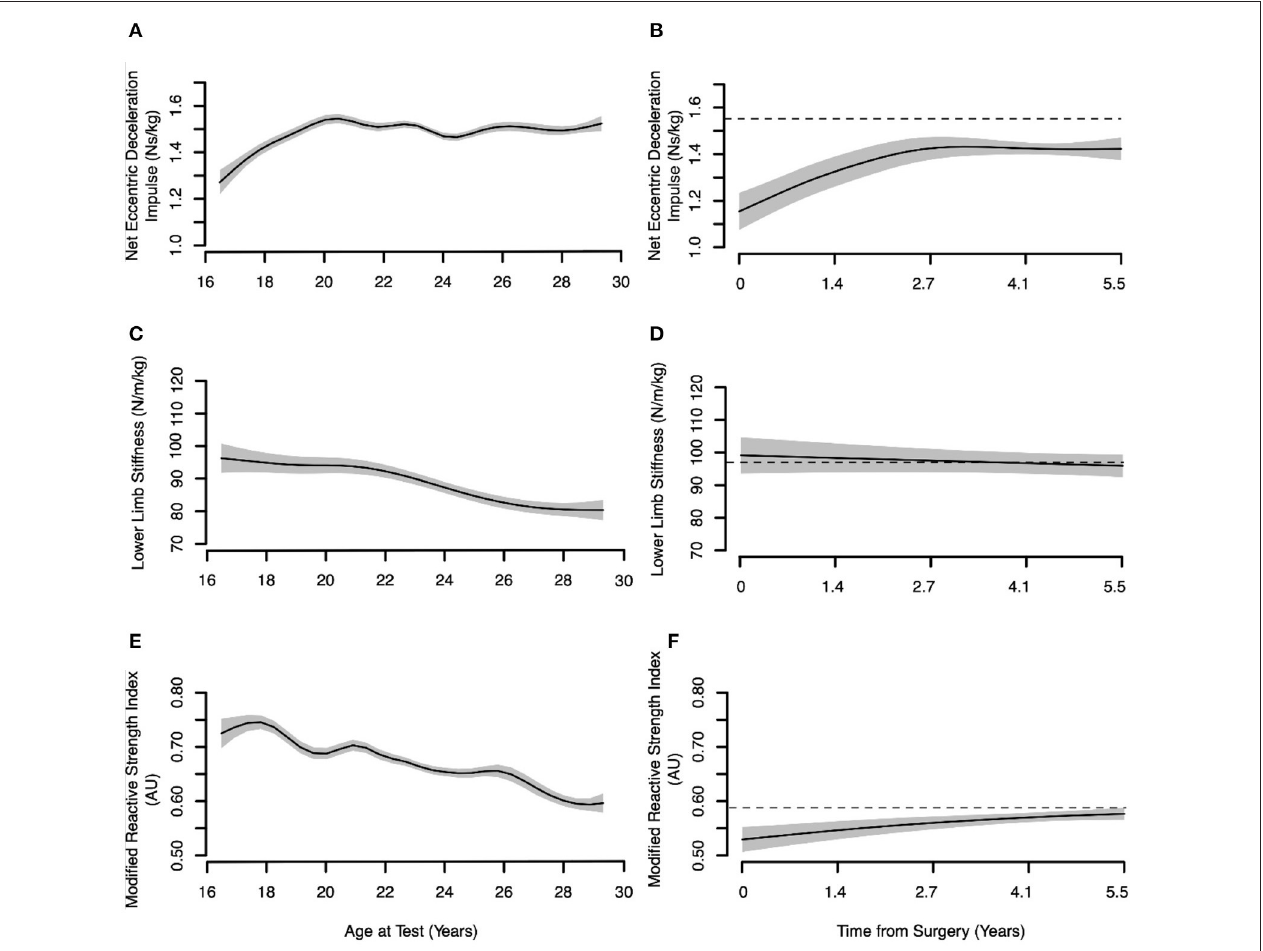
FIGURE 3 | Age-dependent changes in eccentric deceleration phase jump measures and modified reactive strength index for non-injured controls and the post-surgical time-dependent change for the anterior cruciate ligament reconstructed (ACLR) group. The dashed black line shows mean values for non-injured controls > 25 years of age. Solid black lines show the mean value for the typical athlete ± the 95% CI marked in gray shading. (A) Net eccentric deceleration impulse control. (B) Net eccentric deceleration impulse ACLR. (C) Lower limb stiffness control. (D) Lower limb stiffness ACLR. (E) Modified reactive strength index control. (F) Modified reactive strength index